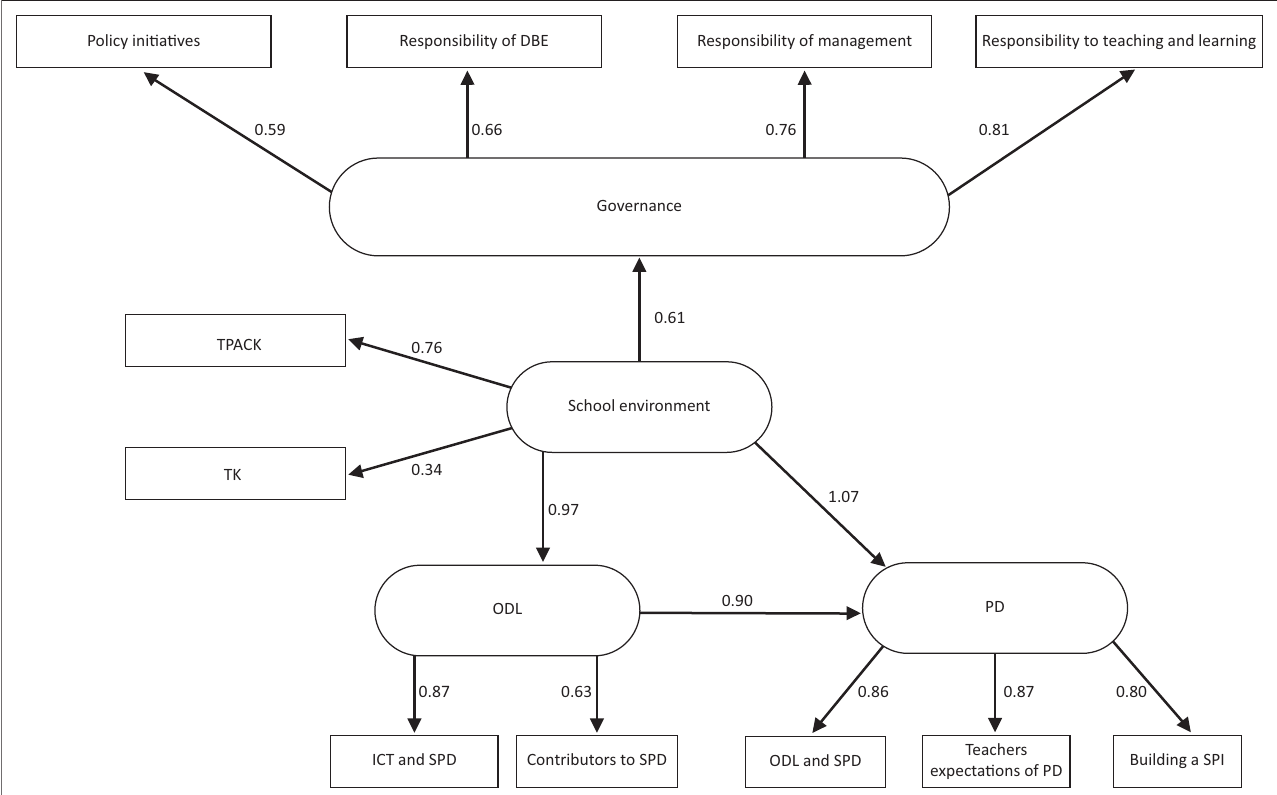
FIGURE 1: Structural equation model from governance, school environment, open distance learning and professional